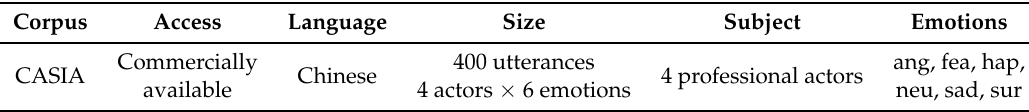
Table 1. Attribute of Chinese speech database.